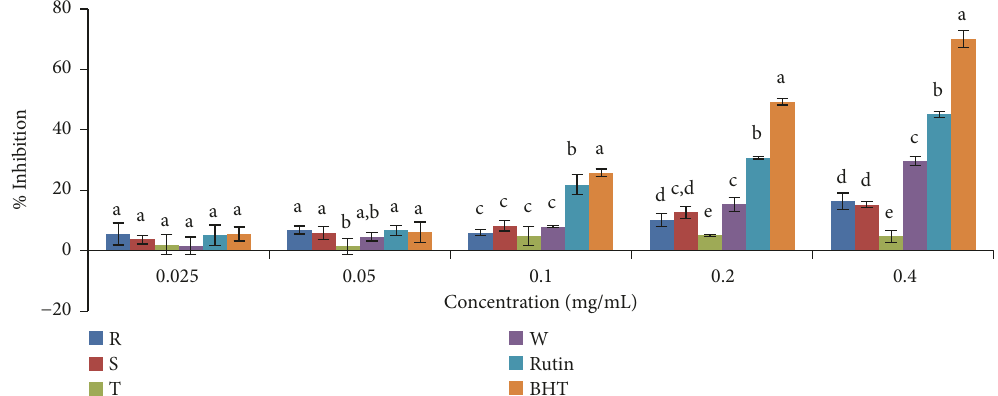
Figure 7: NO scavenging activity of aqueous extract of the four varieties of Capsicum species. Values are mean ± SD of three replications. Set of bars having different letters are significantly different at (p < 0.05). R= C. annuum var. abbreviatum , S= C. annuum var. acuminatum , T= C. annuum var. grossum , and W= C. frutescens var . baccatum .